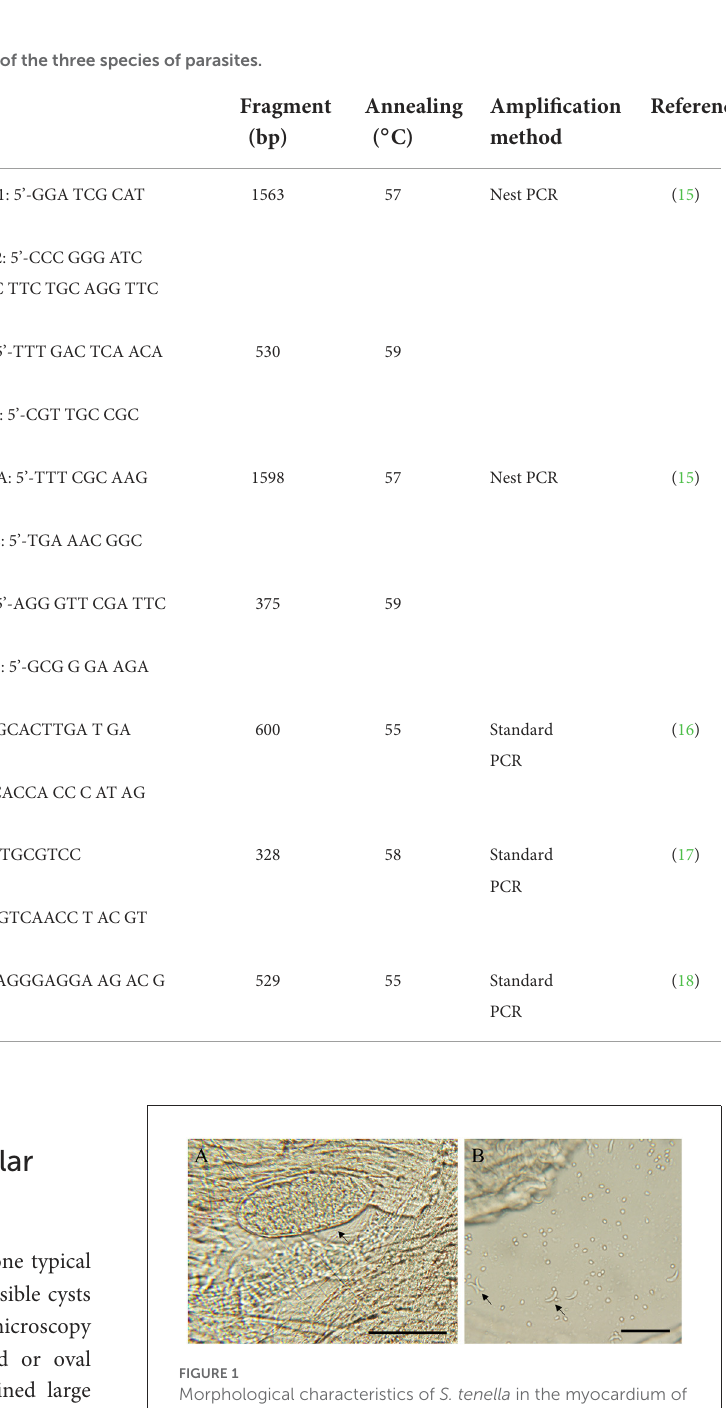
Of the 83 muscle samples collected from Beijing, 36 (43.4%, 95% CI: 32.5–54.7) and 0 (0.0%, 95% CI: 0.0–4.3) tested